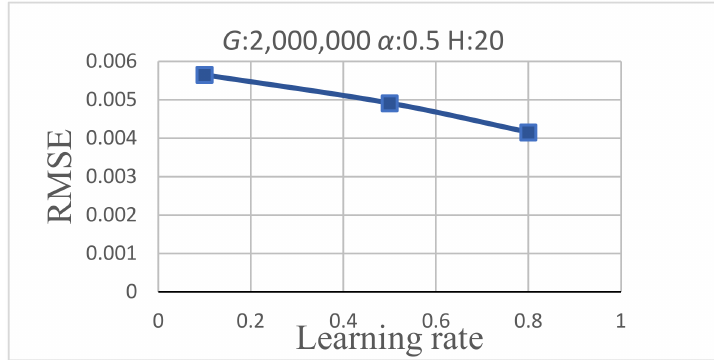
Figure 9. Learning rate variables for RMSE.